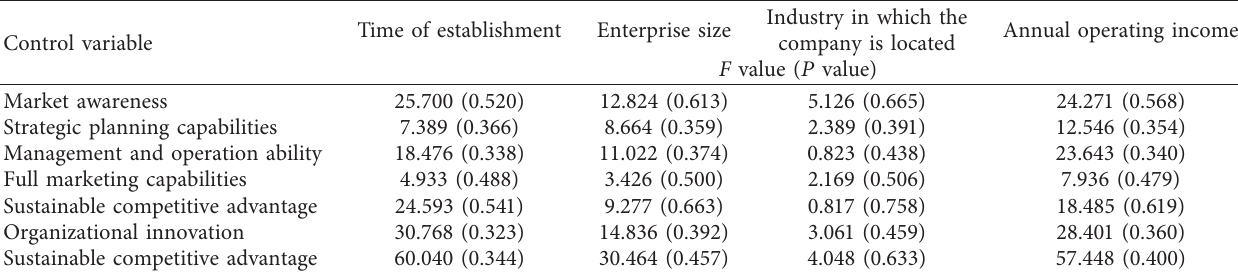
Figure 2: Discriminant validity analysis results of variables. (a) Market awareness. (b) Strategic planning capabilities. (c) Management and operation ability. (d) Full marketing capabilities. (e) Sustainable competitive advantage. (f) Organizational innovation. (g) Sustainable competitive advantage. Table 2: ANOVA results of control